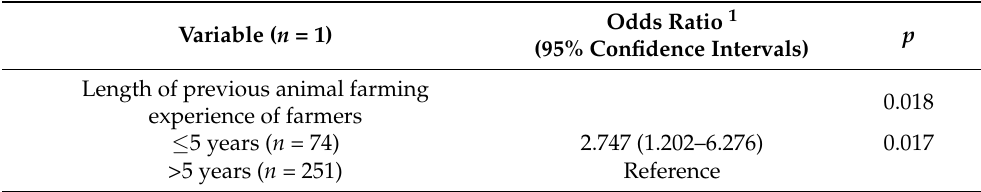
Figure 2. Proportion of flocks from which oxacillin-resistant staphylococcal isolates were recovered, in accordance with the length of previous animal farming experience of farmers in these flocks. Table 2. Results of multivariable analysis for isolation of oxacillin-resistant staphylococcal isolates from the bulk-tank milk of 325 sheep flocks in Greece.